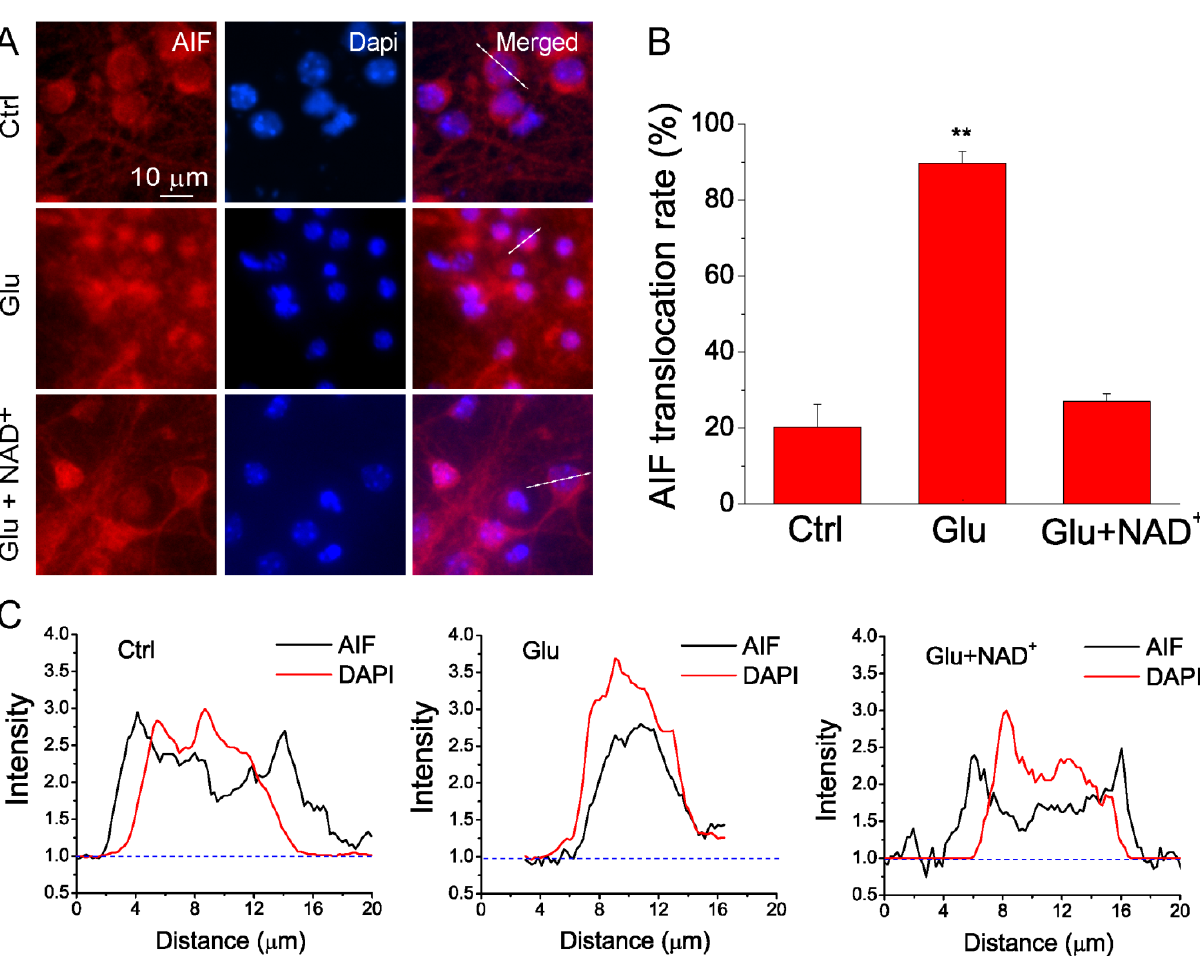
Figure 2. NAD + prevents the translocation of apoptotic inducing factor (AIF) from mitochondria to nucleus after glutamate excitotoxicity. ( A ) Representative images of primary neuronal cultures stained with AIF antibody. Neurons were treated with 100 μM glutamate together with 10 μM glycine in the absence and presence of 15 mM NAD + for 3 h. Nuclei were counterstained with DAPI. Translocation of AIF from mitochondria to nuclei is illustrated by the overlap of AIF (red) and DAPI (blue) staining; ( B ) Summary of AIF translocation after glutamate stimulation. Data was quantified by the number of cells with overlap of AIF and DAPI among the total number of cells determined by DAPI staining. Data are shown as mean ± SE; n = 2–3 coverslips per experimental condition from three independent experiments. ** p < 0.01 versus Ctrl and Glu + NAD + , ANOVA test; ( C ) Line-scan of AIF and DAPI fluorescence from the cells indicated in ( A ). The fluorescence was normalized to the background. Notice the translocation of AIF after glutamate stimulation and prevention of AIF translocation by NAD +